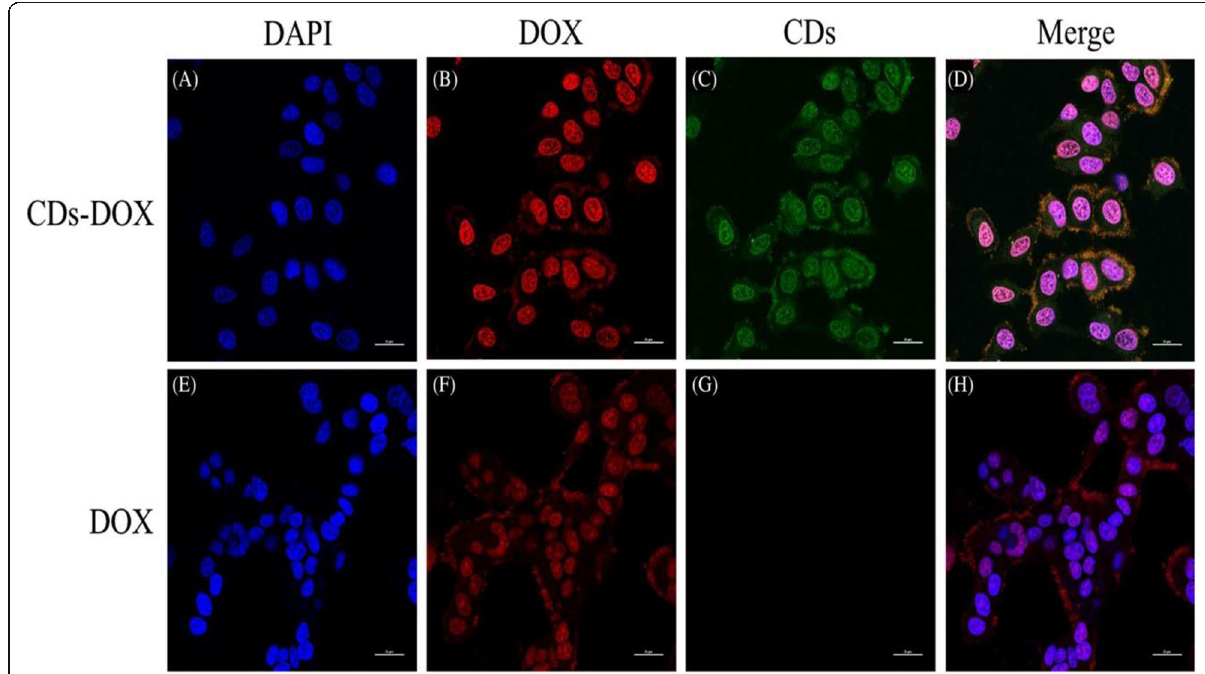
Fig. 8 Confocal microscopy images of CDs-DOX a , b , c , and d and DOX e , f , g , and h incubated MCF-7 cells for 4 h, respectively. [ “ Reprinted (adapted) with permission from [33]. Copyright 2018 John Wiley & Sons Ltd. ”